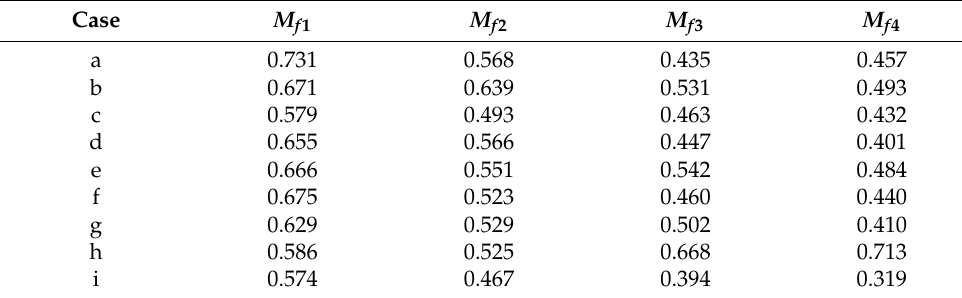
Table 3. The M f values of the egg cross-sections 1, 2, 3, and 4.